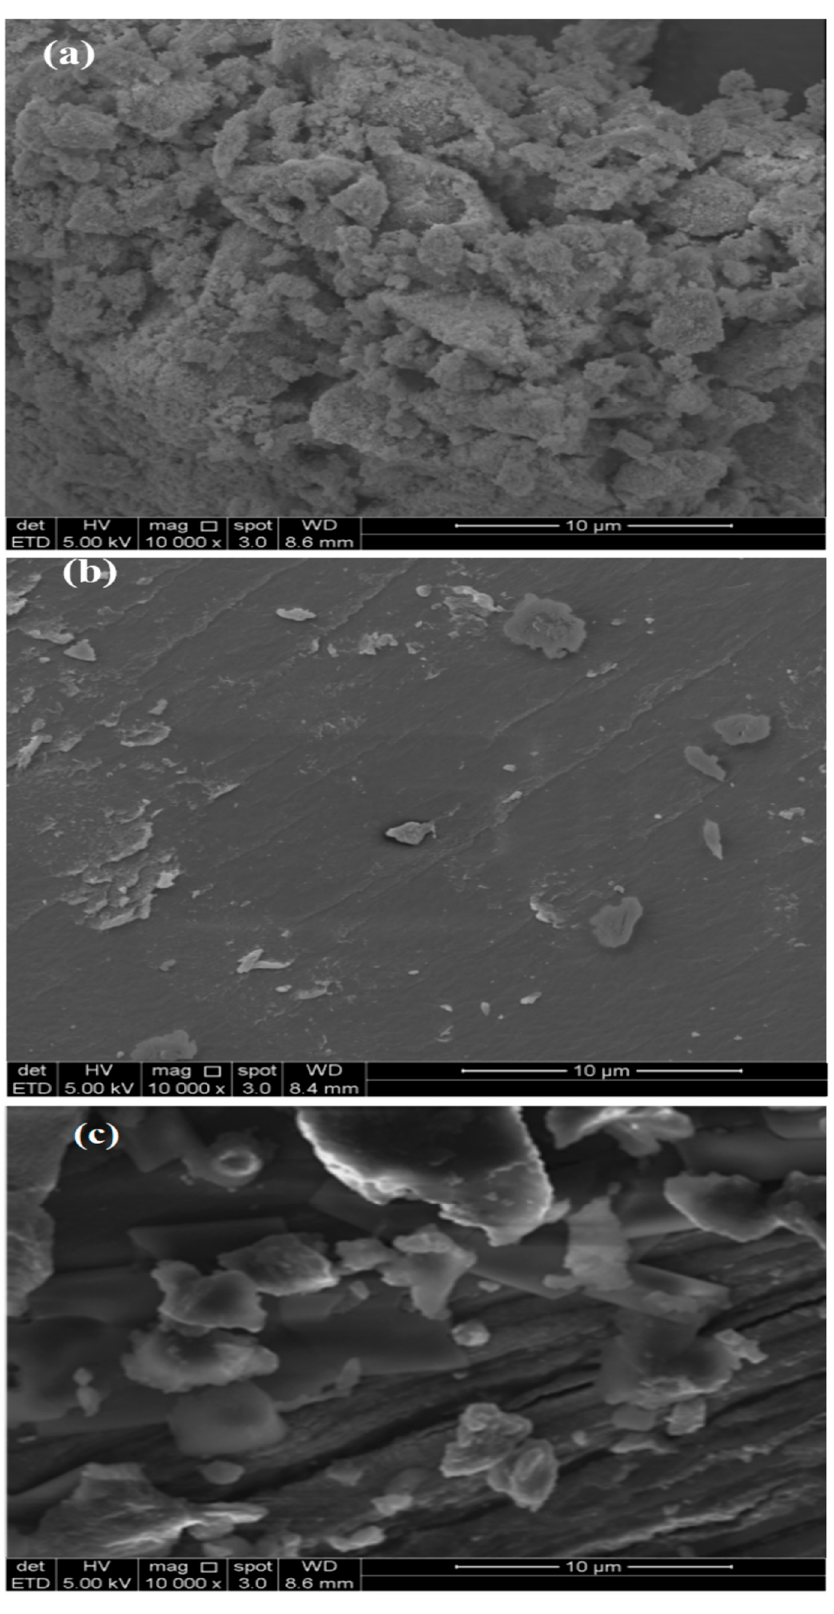
Figure 3. SEM images for ( a ) Fe 3 O 4, ( b ) GA, and ( c ) GA-MNPs.